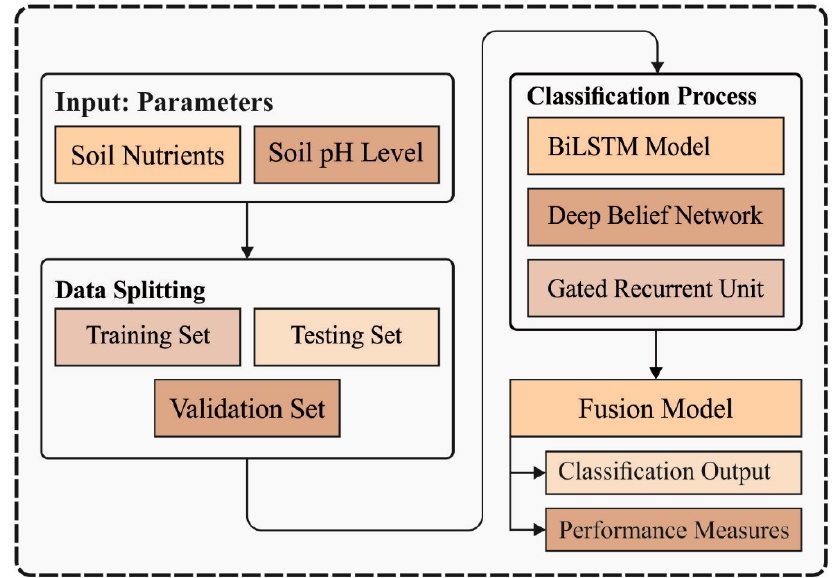
Figure 1. Overall process of ISNpHC-WVE model.